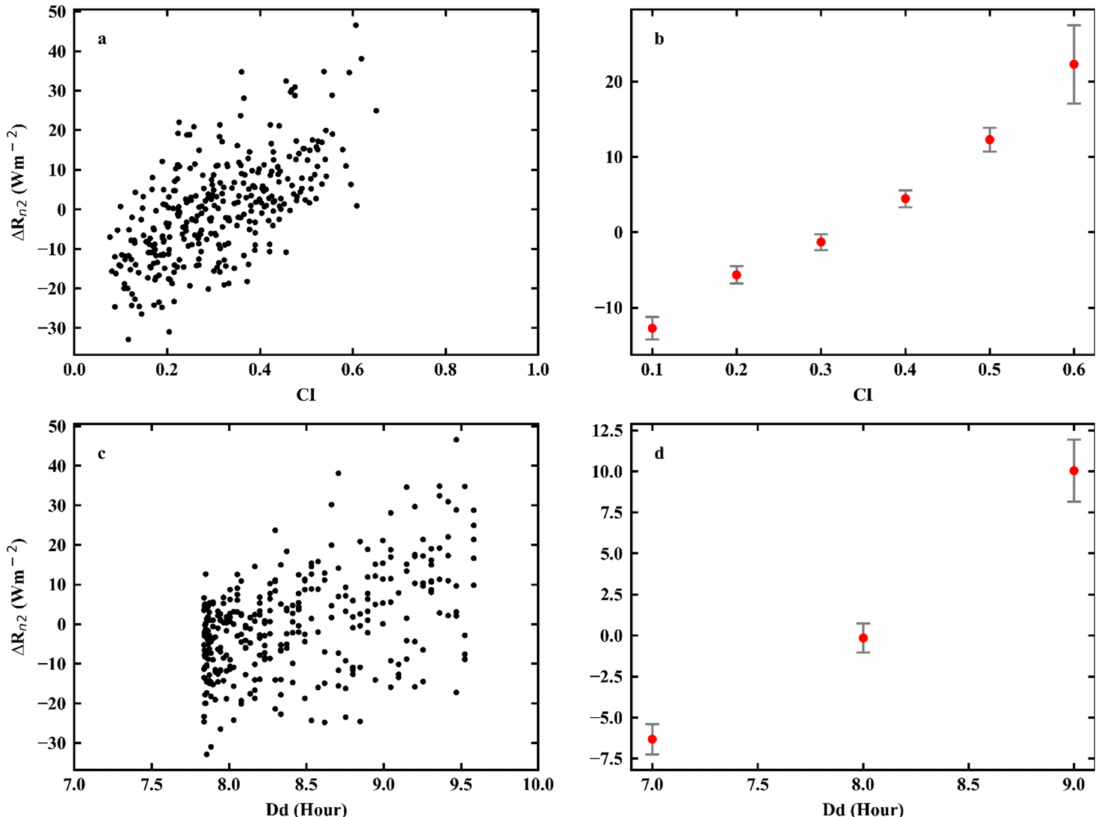
Figure 7. The same as Figure 4 but for the model residuals ∆ R n2 and CI and